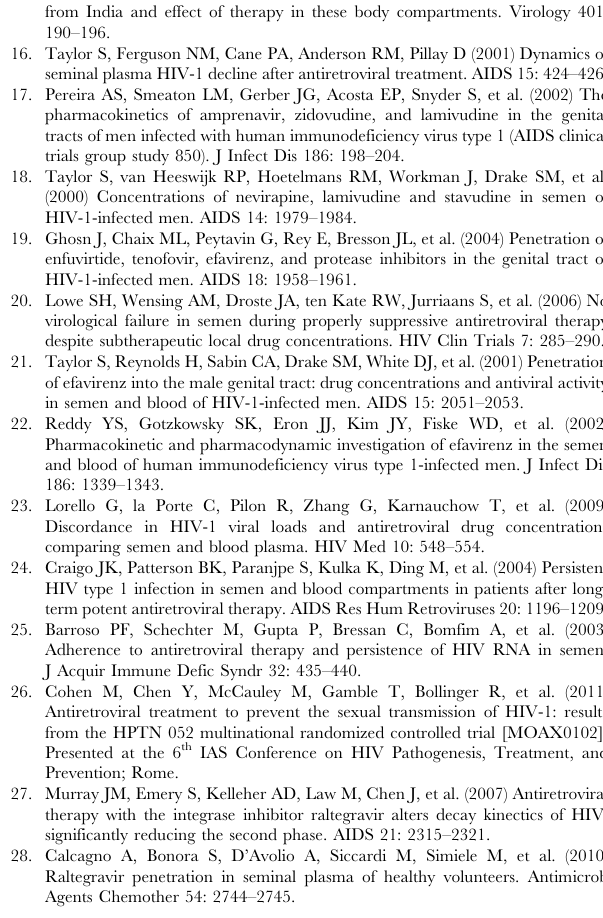
Figure 1. Decrease in HIV-1 RNA in blood and semen during the first month of antiretroviral therapy. Figure 1a presents results for blood plasma, and Figure 1b presents results for seminal plasma. Open, connected circles represent included data points (see methods). The bold line represents the modeled estimate. Delta ( d ) is the estimate for the initial, rapid phase of decay, and mu ( m ) the estimate for the subsequent, slower phase of decay. The half-life in days for each phase is equal to ln(2) divided by the decay rate in log 10 virions/day. P values are presented for comparisons of the two decay rates in seminal plasma to those seen in blood plasma. NA=not applicable.